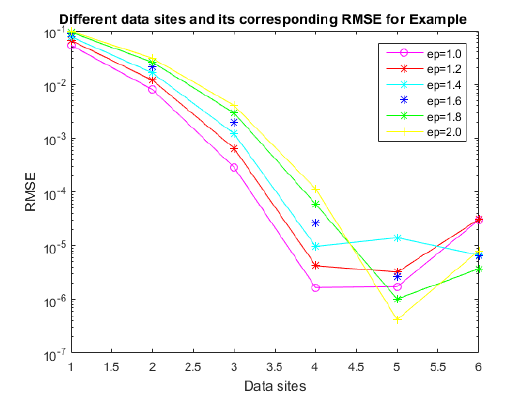
Figure 4. Error Comparison for Example 2